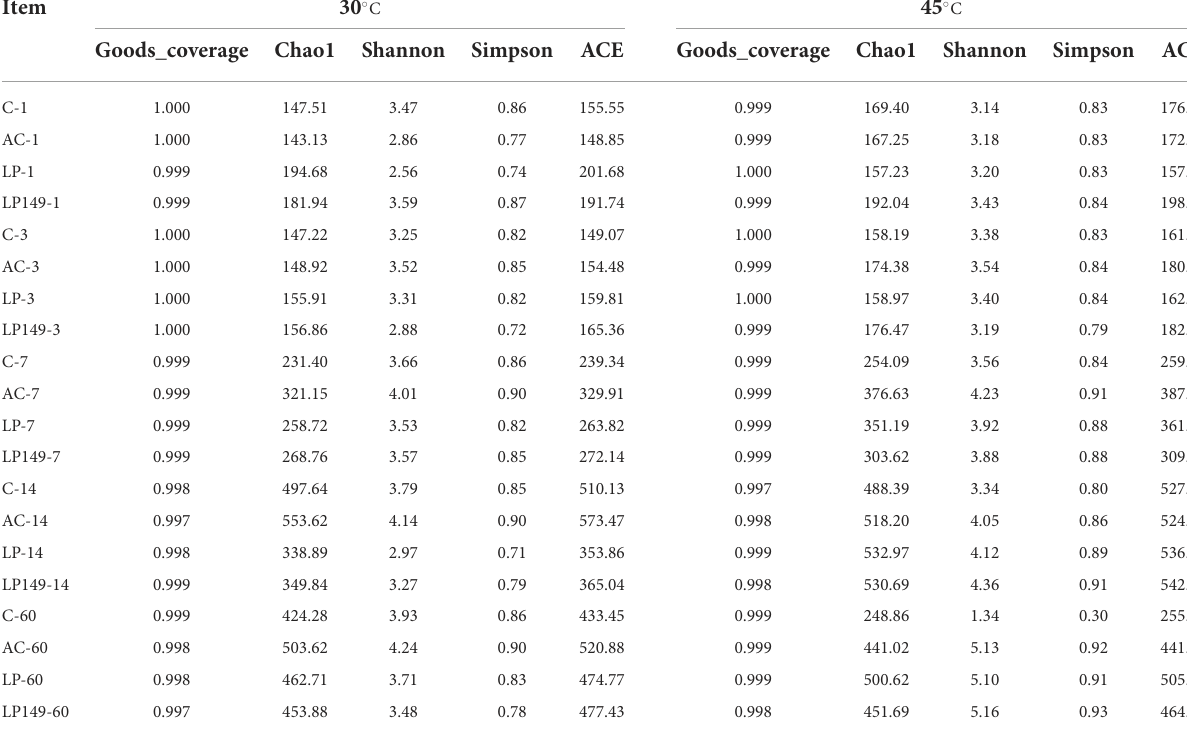
TABLE 3 Alpha diversity of hybrid elephant grass silages treated with additives at different ensiling times and